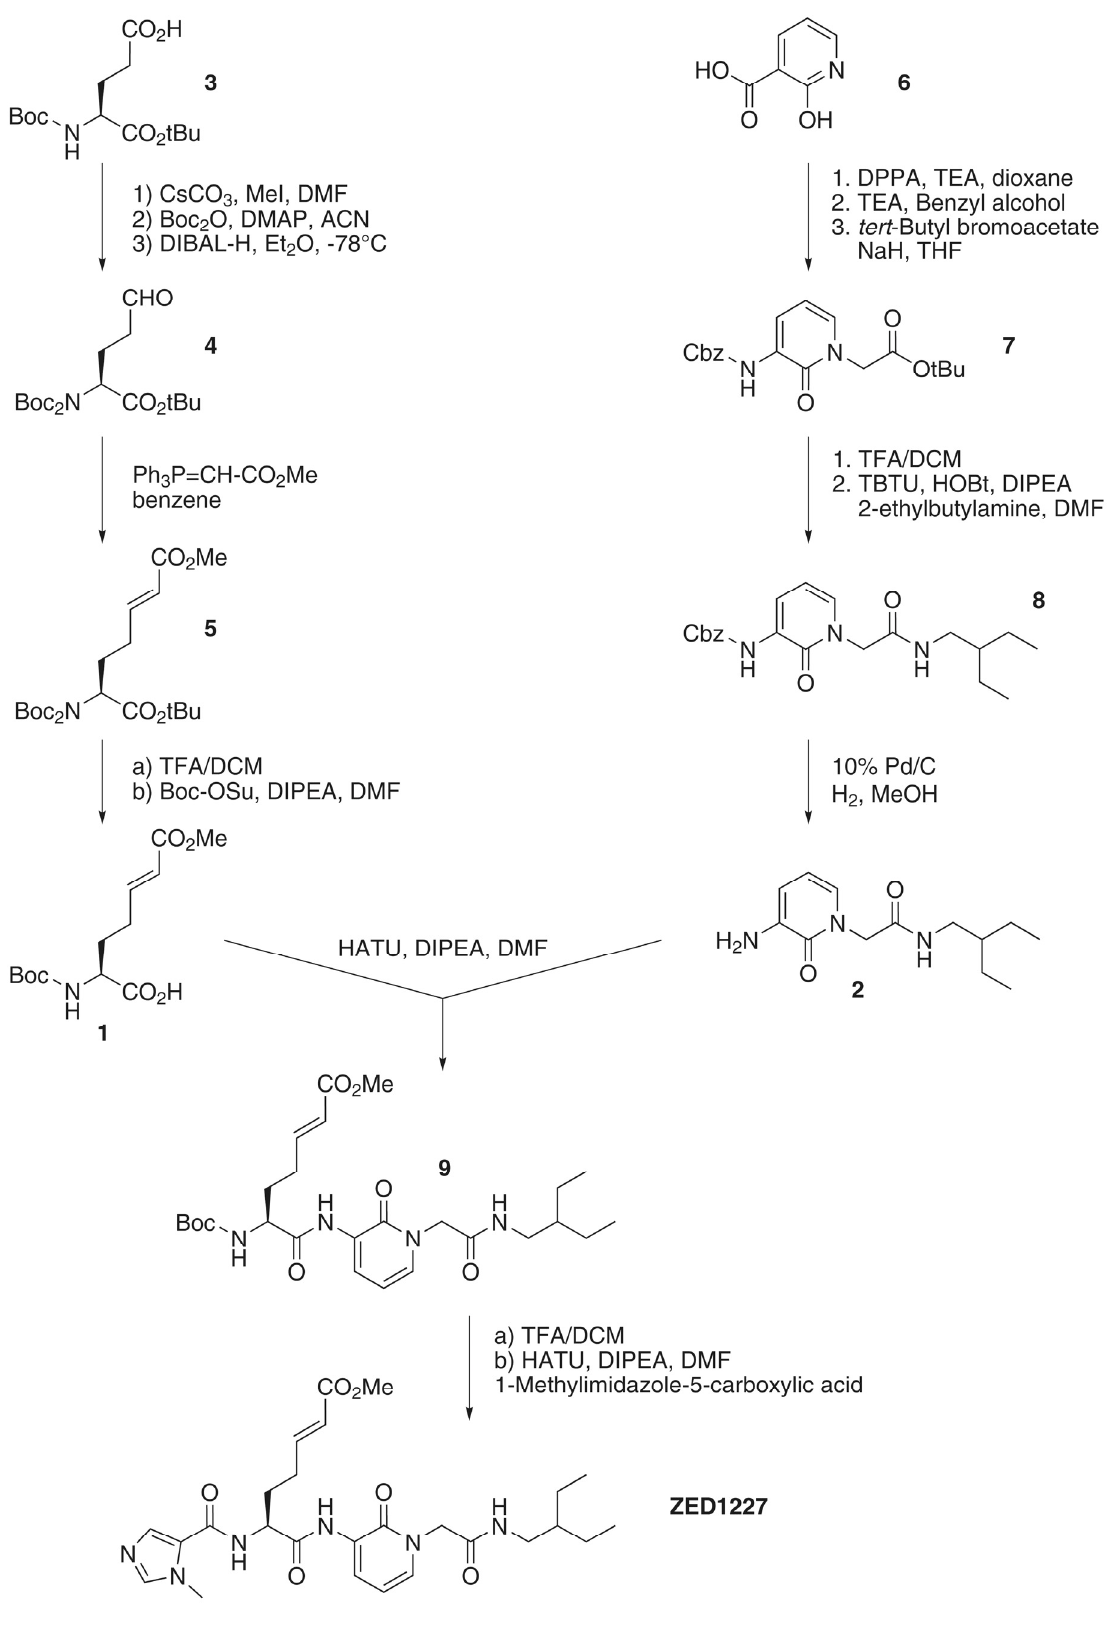
Figure 1. Synthesis scheme of ZED1227. Abbreviations used are included in Appendix